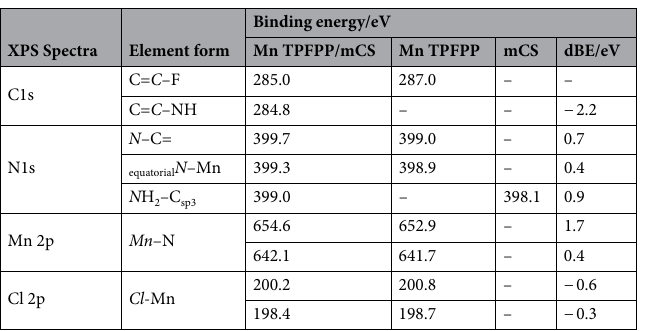
Table 3. Electron Binding energy for key elements in mCS, Mn TPFPP and Mn